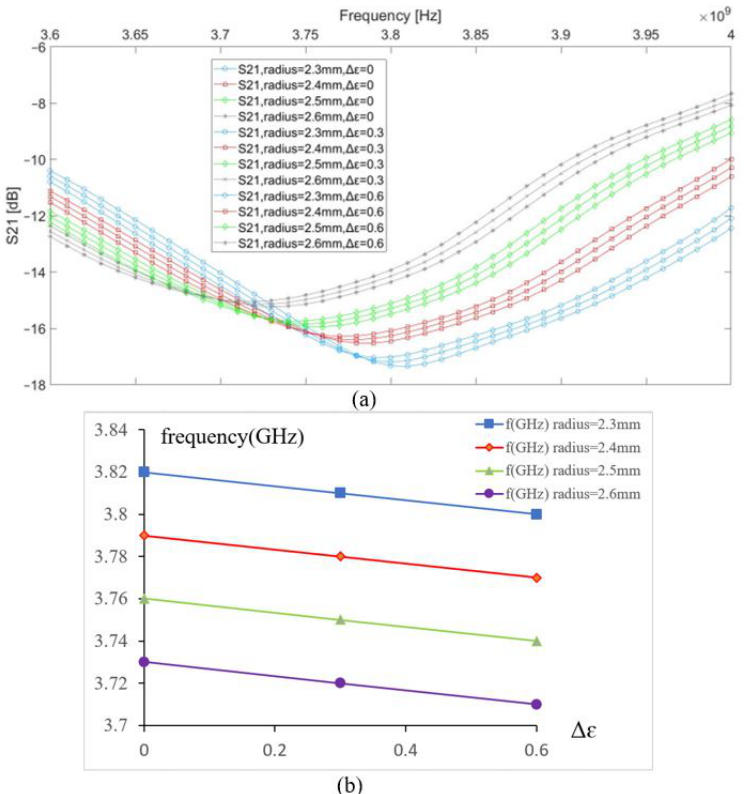
Figure 3. ( a ) S21 vs. frequency, ( b ) resonance frequency shift vs. permittivity change in the